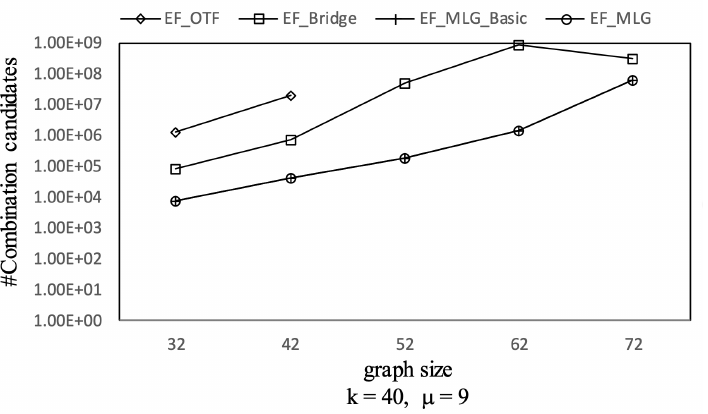
Figure 8. Combination pruning on GraphGen vs. graph size with k = 40 and µ =